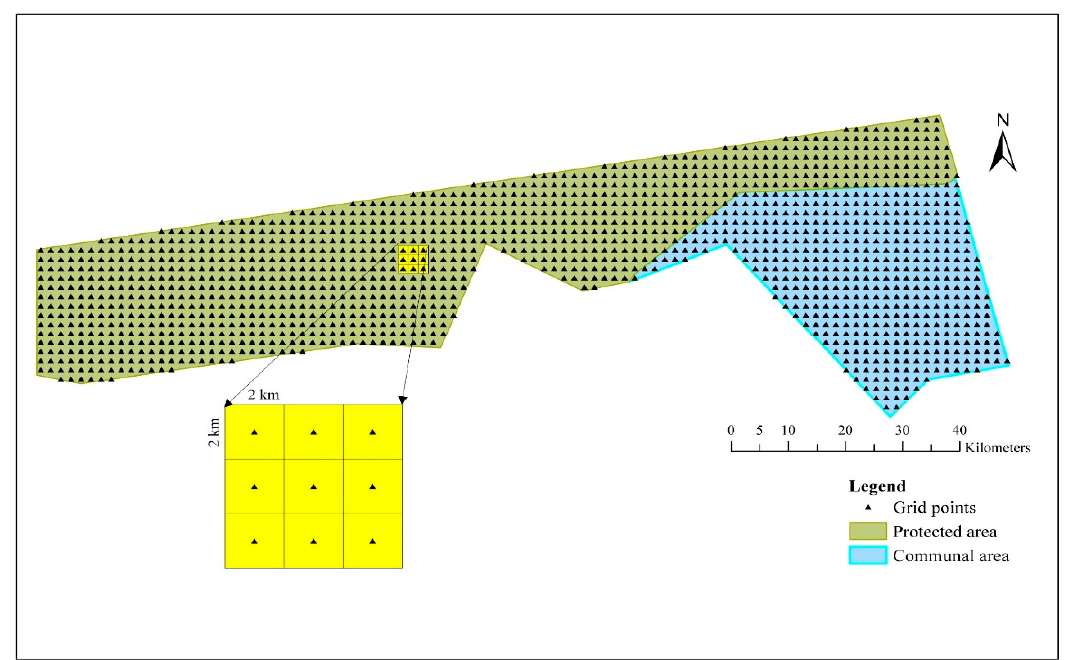
Figure 2. Distribution of surveyed points in the study area.